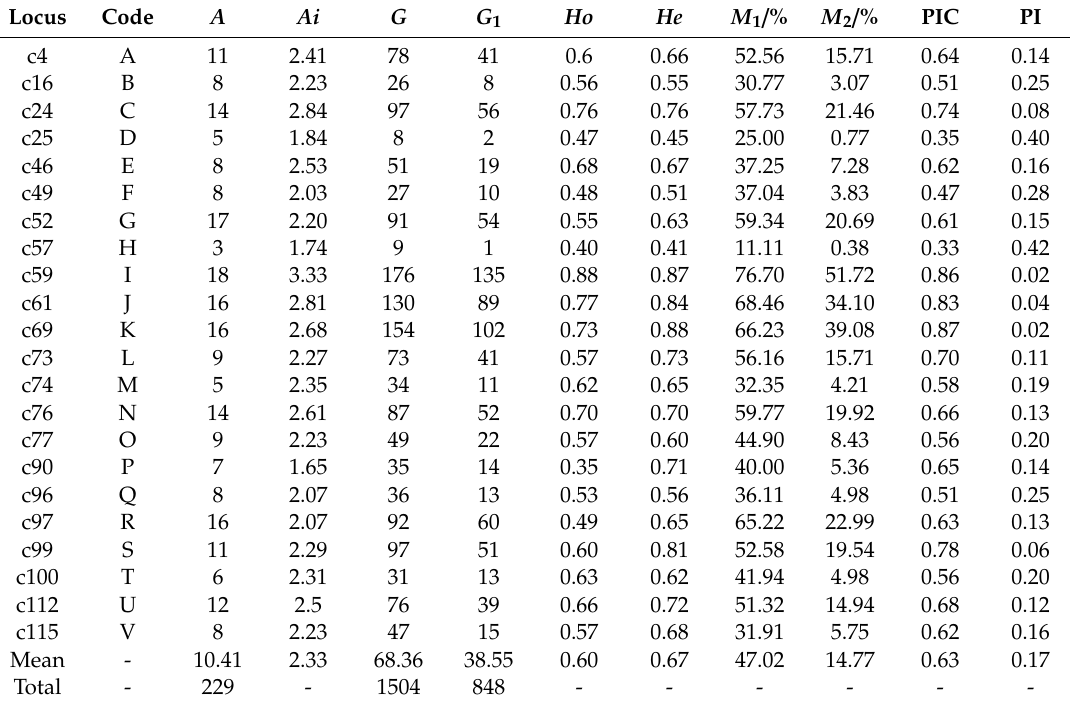
Table 1. Polymorphism and genetic metrics of the 22 pairs of SSR (Simple Sequence Repeat) markers.